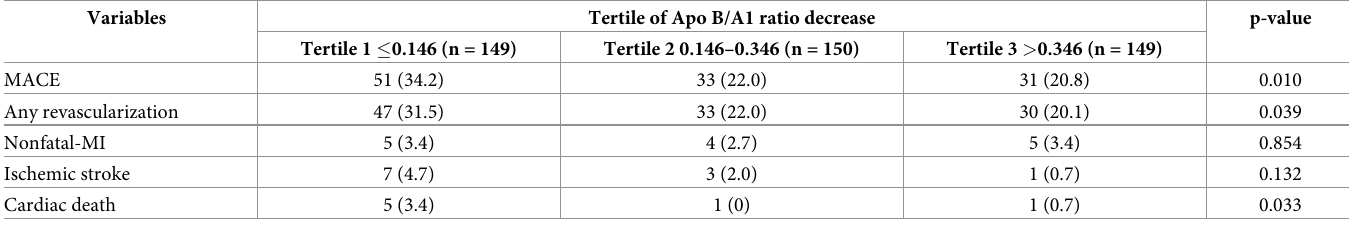
Table 2. Clinical adverse events stratified by tertiles of Apo B/A1 ratio decrease.